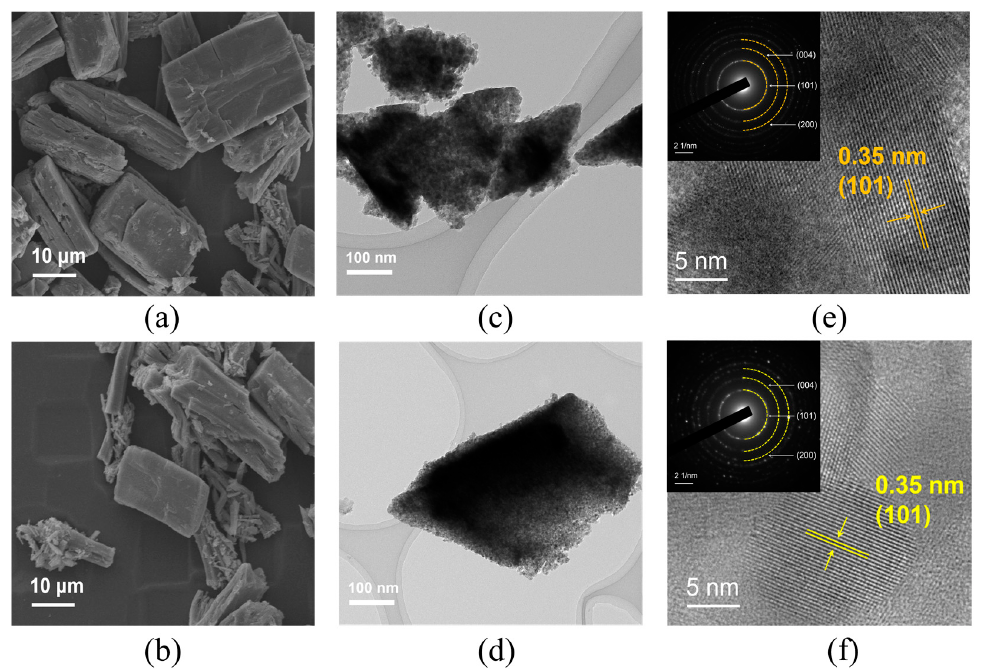
Figure 1. ( a ) SEM, ( c ) TEM, and ( e ) HRTEM images of TiO 2 . ( b ) SEM, ( d ) TEM, and ( f ) HRTEM images of Co@TiO 2 . The insets in ( e , f ) are the TiO 2 - and Co@TiO 2 -related SAED patterns, respectively.